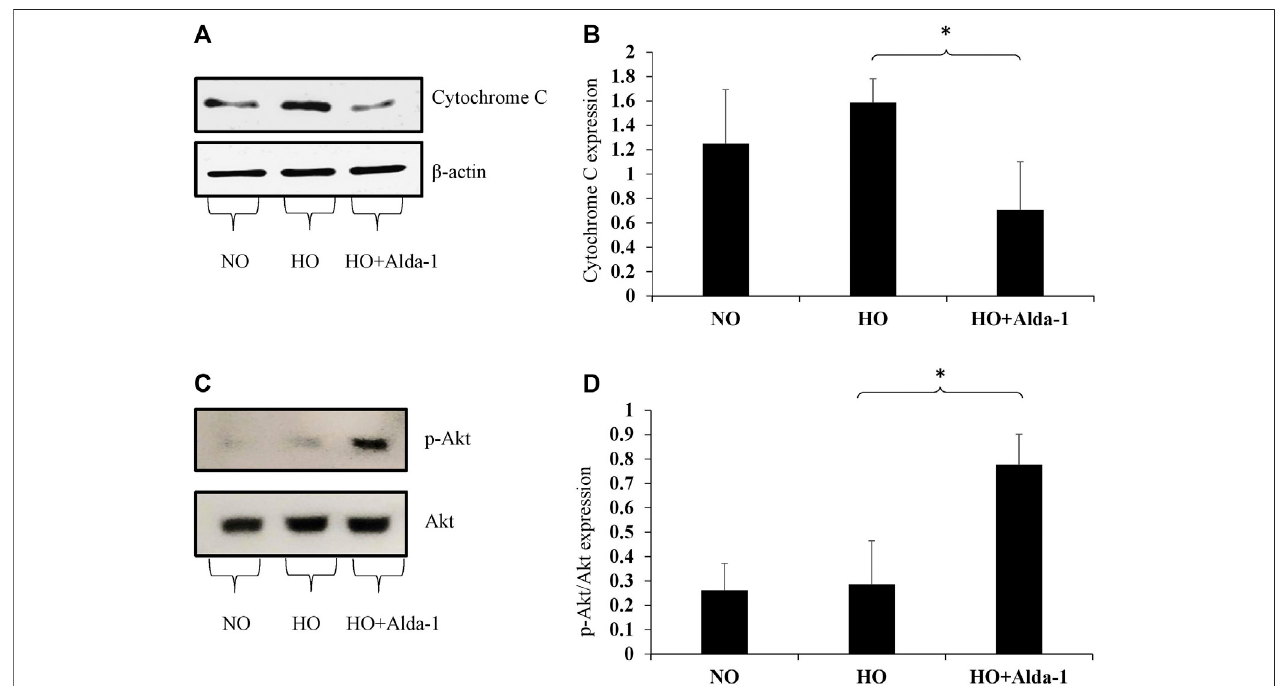
FIGURE 3 | Alda-1 suppresses oxidative stress: Three groups of C57BL/6 mice received exposure to normoxia, hyperoxia, or hyperoxia + Alda-1 for 48 h. Whole cell lysate collected from lung samples was subjected to western blot analysis for cytochrome c (A) and p -Akt (C) ; β -actin and Akt were used as loading controls, respectively. Densitometry analysis shows the expression of cytochrome c (B) and p -Akt (D) . Representative blots from at least three mice/group, (* p < 0.05, ** p <